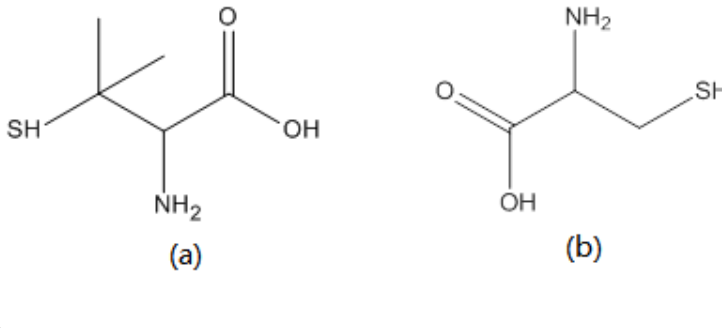
Figure 3. Chemical structures of (a) D -pencillamine and (b)